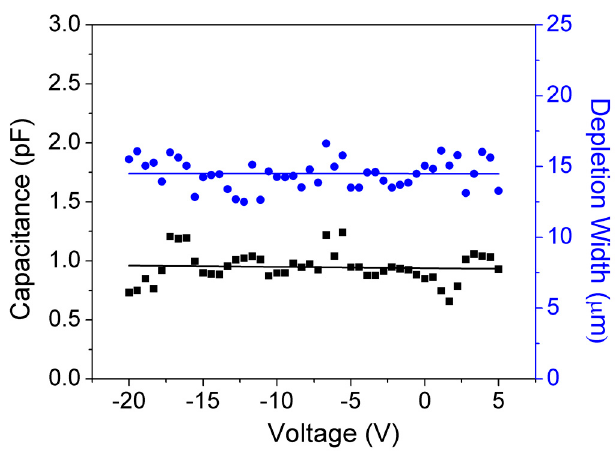
Figure 11. Variation of capacitance and DW with voltage of 0.5 mm diameter GaN SBDs with 15 μ m.